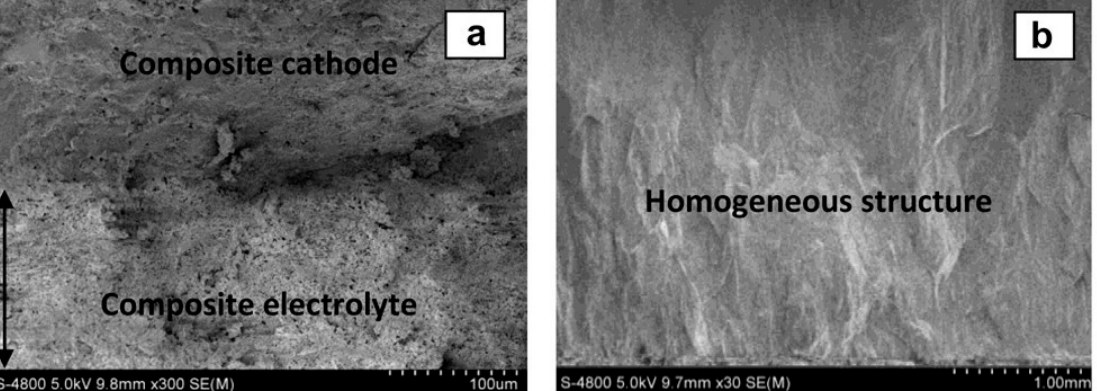
Figure 11. Scanning electron micrograph of the electrolyte structure: ( a ) before cell testing at room temperature and ( b ) after cell testing at T=700 °C.